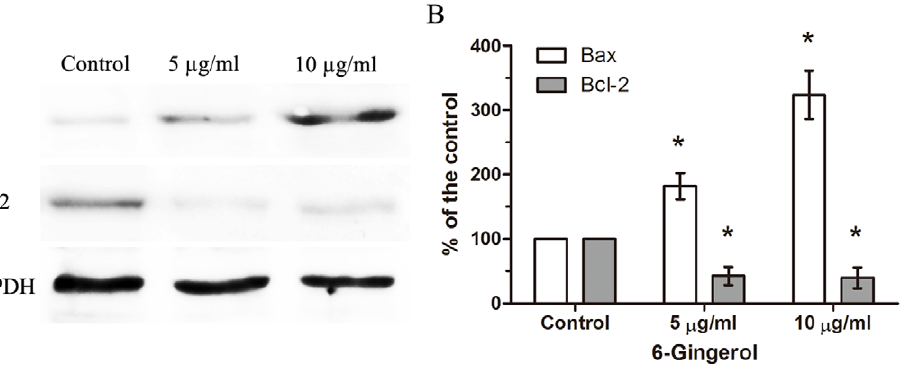
Figure 2. Effect of 6-gingerol on the expression of Bcl-2 and Bax proteins in cultured human DPCs. (A) DPCs were treated with the indicated concentrations of 6-gingerol (0.1% DMSO control) for 48 h and subjected to western blot analysis. Representative bands are shown. (B) Histograms showing the quantification of western blot bands. GAPDH was used as the internal control. * P , 0.05 compared to the control (0.1% DMSO) group.